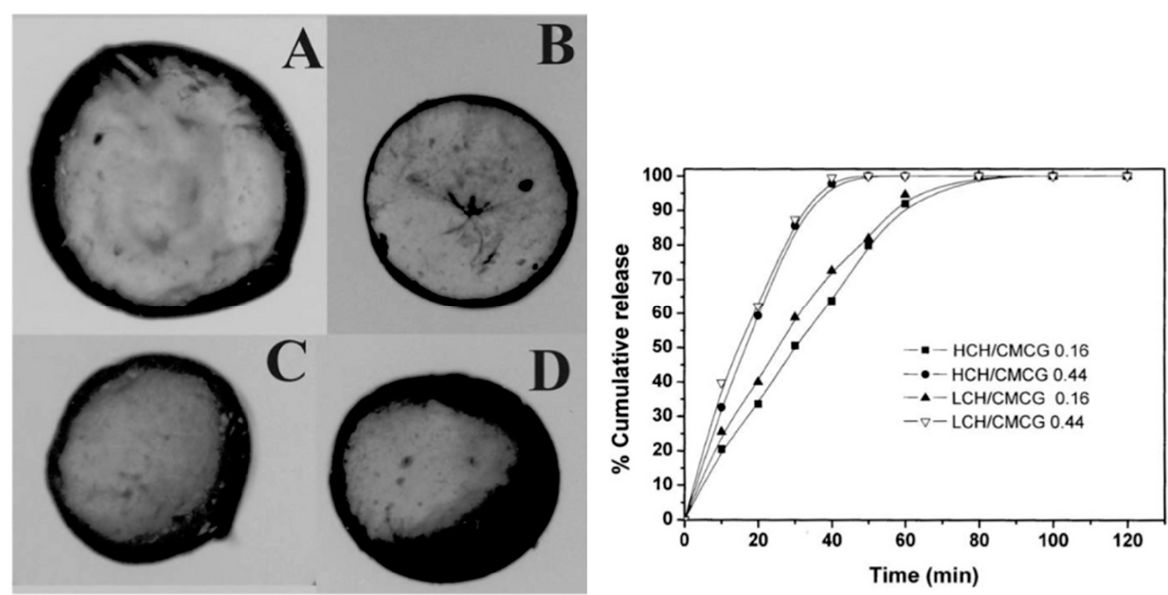
Figure 5. Optical microscopy of different chitosan/carboxymethyl cashew gum (CH/CMCG) micro- spheres. ( A ) HCH/CMCG 0.16; ( B ) HCH/CMCG 0.44; ( C ) LCH/CMCG 0.16; and ( D ) HCH/CMCG 0.44 and effect of chitosan (CH) molar mass and degrees of substitution (DS) of chitosan/carbox- ymethyl cashew gum (CMCG) on in vitro release profile of BSA (Adapted from Magalhães et al. (2009) [63] , Copyright© 2009, Elsevier Ltd).